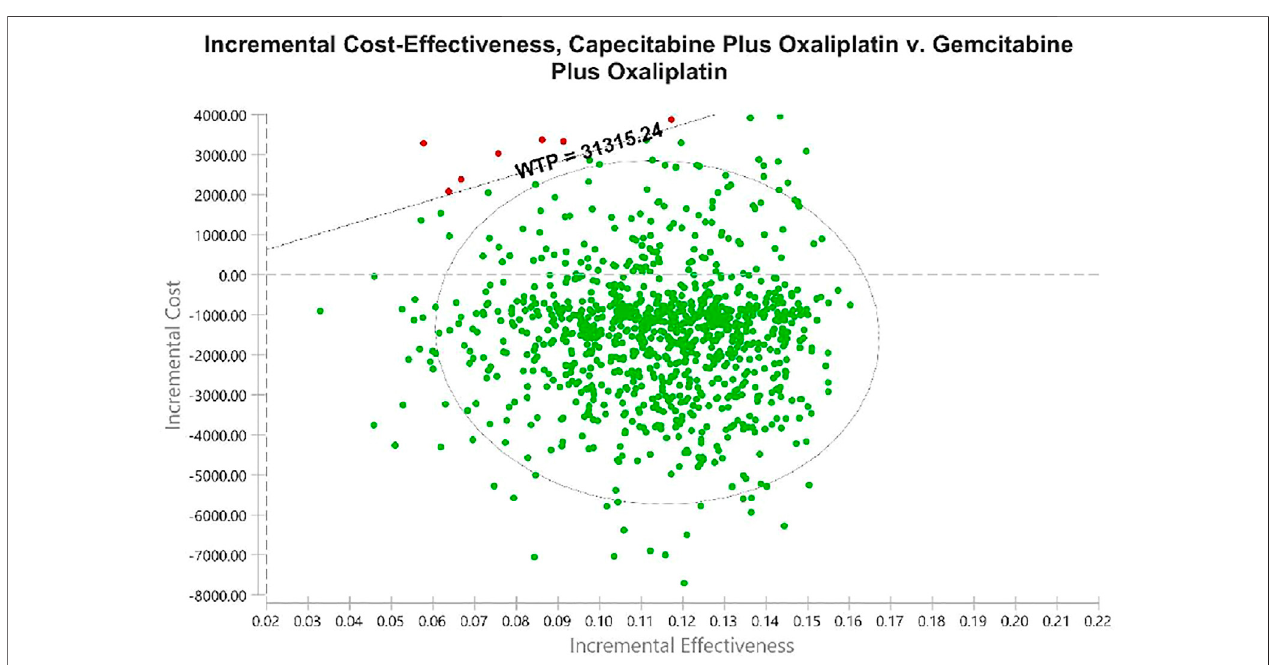
FIGURE3 | Probabilisticsensitivityanalyses.Dots indicate theresults ofMonte Carlosimulations, and ellipses indicate 95% con fi dence intervals. The diagonal line shows WTP. Dots located below the diagonal line indicate cost-effectiveness for the experimental group compared to the corresponding control group. Abbreviations: WTP, willingness to pay. All costs are in United States